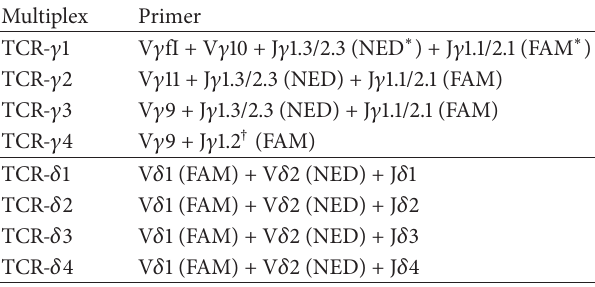
Table 3: Multiplex PCR reactions used for